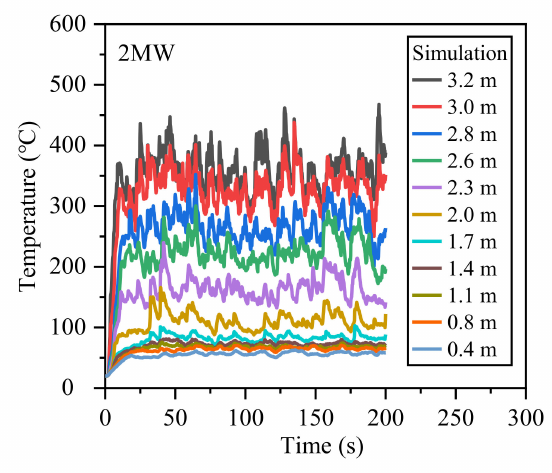
Figure 14. Window edge temperature under window sprinkler conditions.